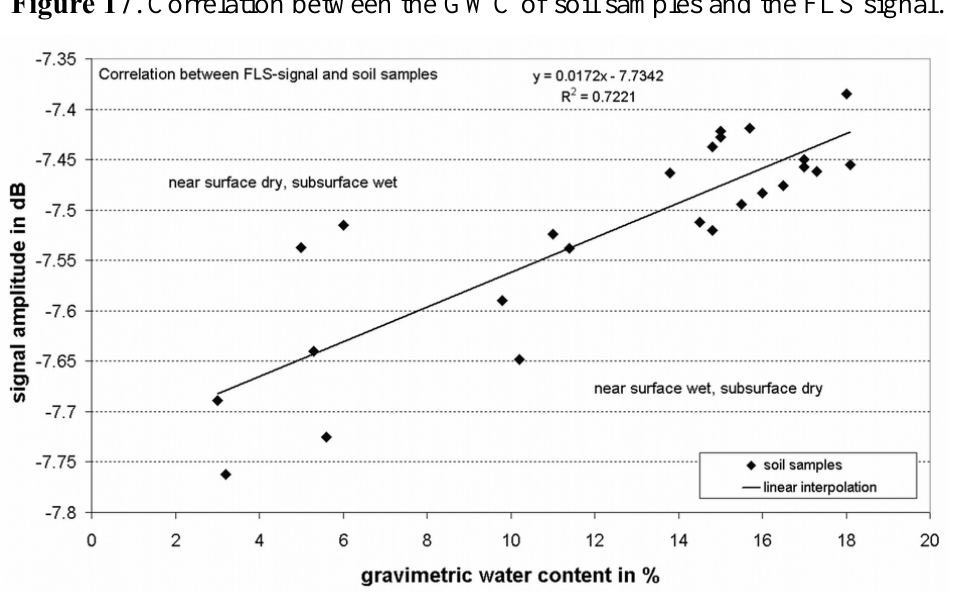
Figure 17 . Correlation between the GWC of soil samples and the FLS